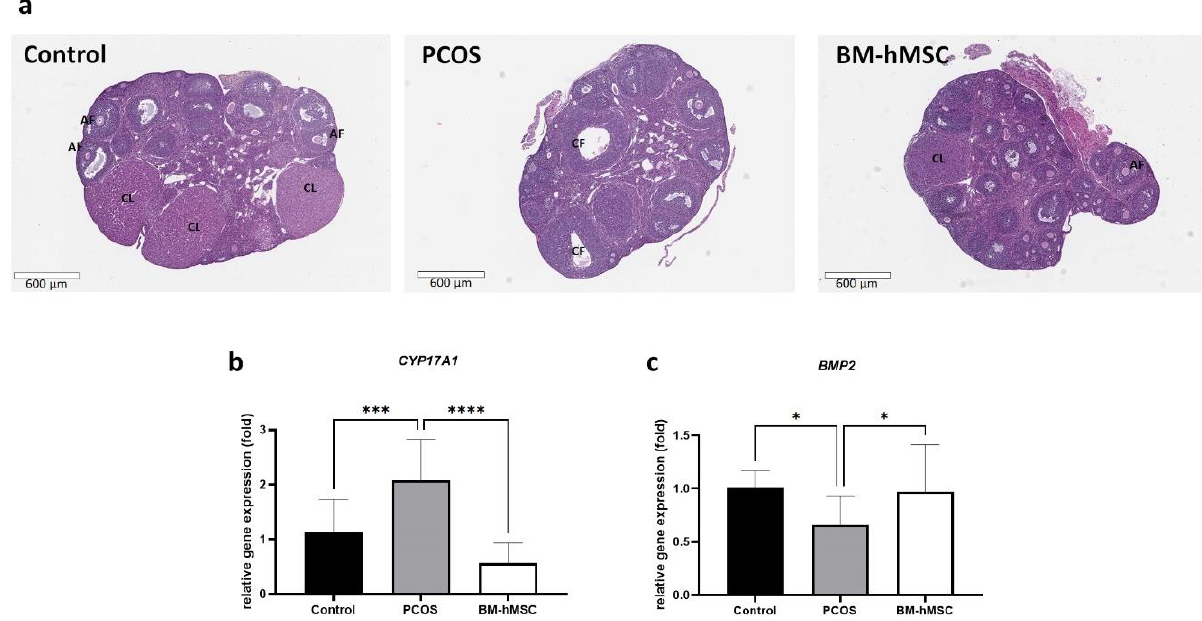
Figure 4. Effect of hBM-MSCs on ovarian tissue. ( a ) Morphology of ovary (H & E staining) in healthy mouse (control), PCOS mouse (PCOS), and BM-hMSC-treated mouse (BM-hMSCs). ( b ) Relative expression of CYP17A1 gene in healthy mouse (control), PCOS mouse (PCOS), and BM-hMSC-treated mouse (BM-hMSCs). ( c ) Relative expression of BMP-2 gene in healthy mouse (control), PCOS mouse (PCOS), and BM-hMSC-treated mouse (hBM-MSCs). Data are presented as the mean ± SD. (Number of animals = 6/group, significance level, * p < 0.05, *** p < 0.0005, **** p < 0.0001).